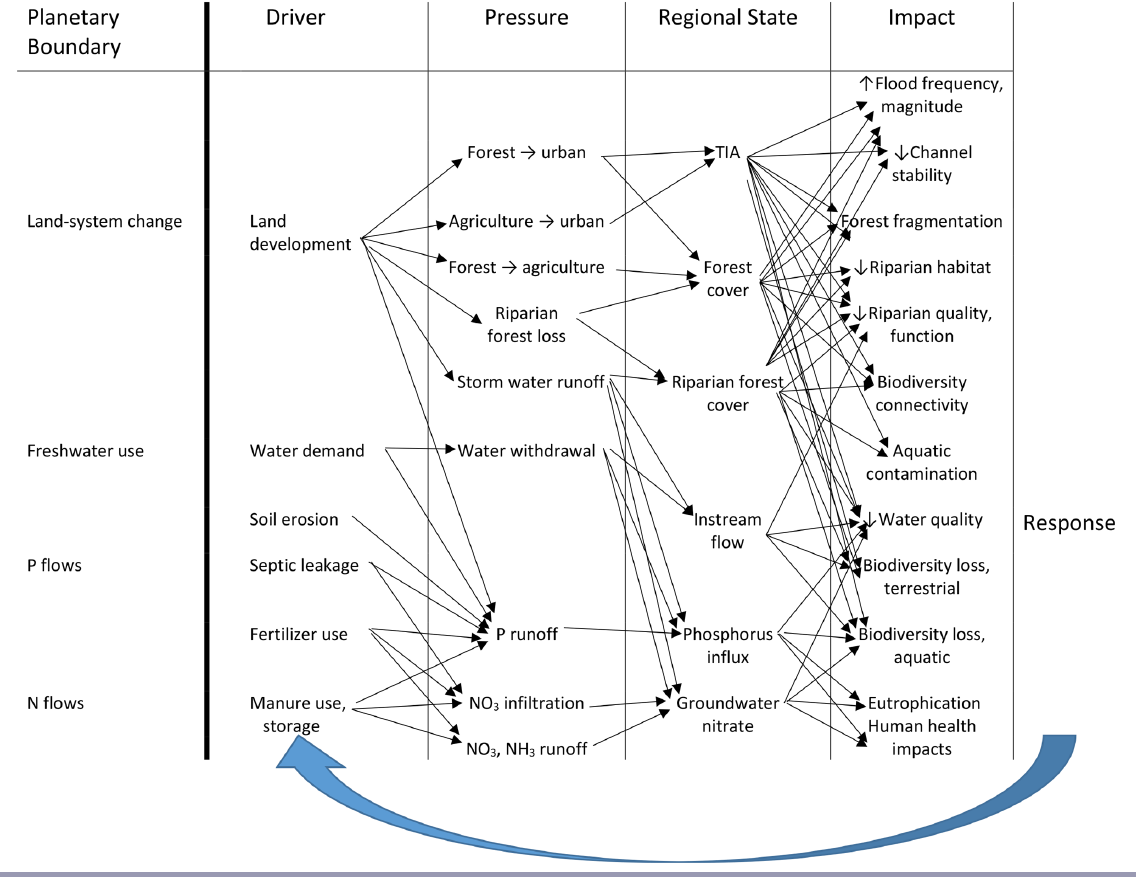
Fig. 1 . Causal chain diagram for regional boundaries, using a driver-pressure-state-impact-response (DPSIR) framework, similar to Nykvist et al. (2013). DPSIR categories are defined in the text. Regional boundaries are safe limits on state variables. Societal responses should modify drivers or pressures to maintain state variables within boundaries. Many impacts function as drivers to other impacts, not shown here. For example, hydrologic impacts also affect biodiversity composition and functions. Planetary analogs to regional boundaries are listed on the left for reference. TIA, total impervious surface